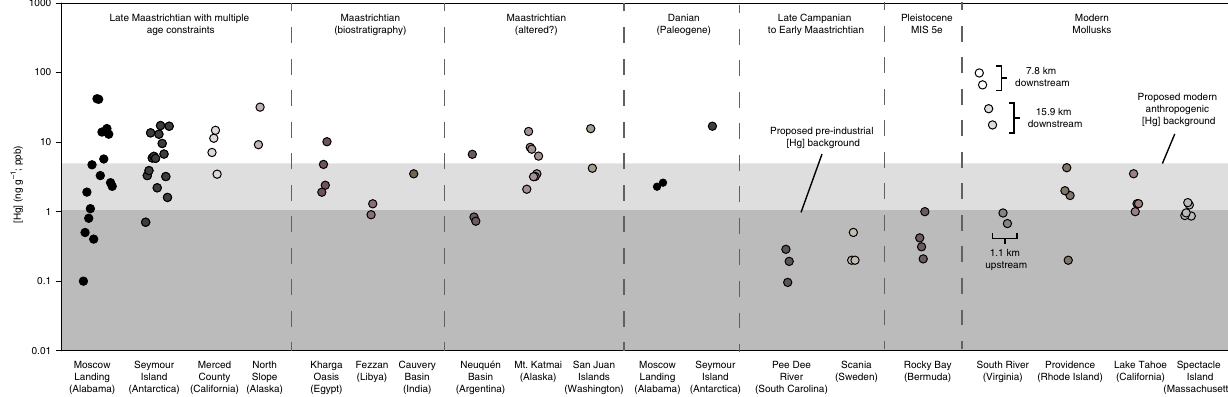
Fig. 4 Modern and ancient mercury concentrations by sample region. Measured [Hg] values in ancient and modern mollusk shells by sample region divided temporally and by quality of age constraints, plotted on a log scale. Samples from Moscow Landing, Seymour Island, Merced County, and North Slope regions all are Late Maastrichtian in age and are constrained by some combination of biostratigraphy, magnetostratigraphy, strontium isotope stratigraphy, and/or the presence of the “ iridium layer. ” Specimens from Kharga Oasis, Fezzan, and Cauvery Basin are acknowledged to be from the Middle to Late Maastrichtian, but only have biostratigraphic age constraints. Mt. Katmai, San Juan Islands, and Neuquén Basin sample regions are acknowledged to be Maastrichtian in age, but based on Δ 47 and/or 87 Sr/ 86 Sr values are possibly diagenetically altered. Pee Dee River, Scania, and Rocky Bay sample regions are known to exist well outside the timing of the Deccan Traps eruptions, exhibit negligible [Hg], and the range of values of these specimens are used to de fi ne a “ Pre-Industrial background ” with [Hg] ≤ 1.3 ng g − 1 . For comparison, modern uncontaminated mollusk samples from Providence, Lake Tahoe, and Spectacle Island de fi ne a “ Modern anthropogenic background ” with [Hg] ≤ 5.0 ng g − 1 . Lastly, the legacy Hg-contaminated South River site depicts samples from various lengths along the stream corridor relative to the point source of Hg contamination, and permits a fi rst-order comparison to the elevated Maastrichtian fossil [Hg] values associated with the Deccan Traps. Uncertainties on any single sample [Hg] value are, on average, ±11% of the measured [Hg] value and are too small to depict on this fi gure (please refer to Methods). Full sample locality details can be found in the Supplementary Note 1. Source data are provided in Supplementary Data Files 2 and